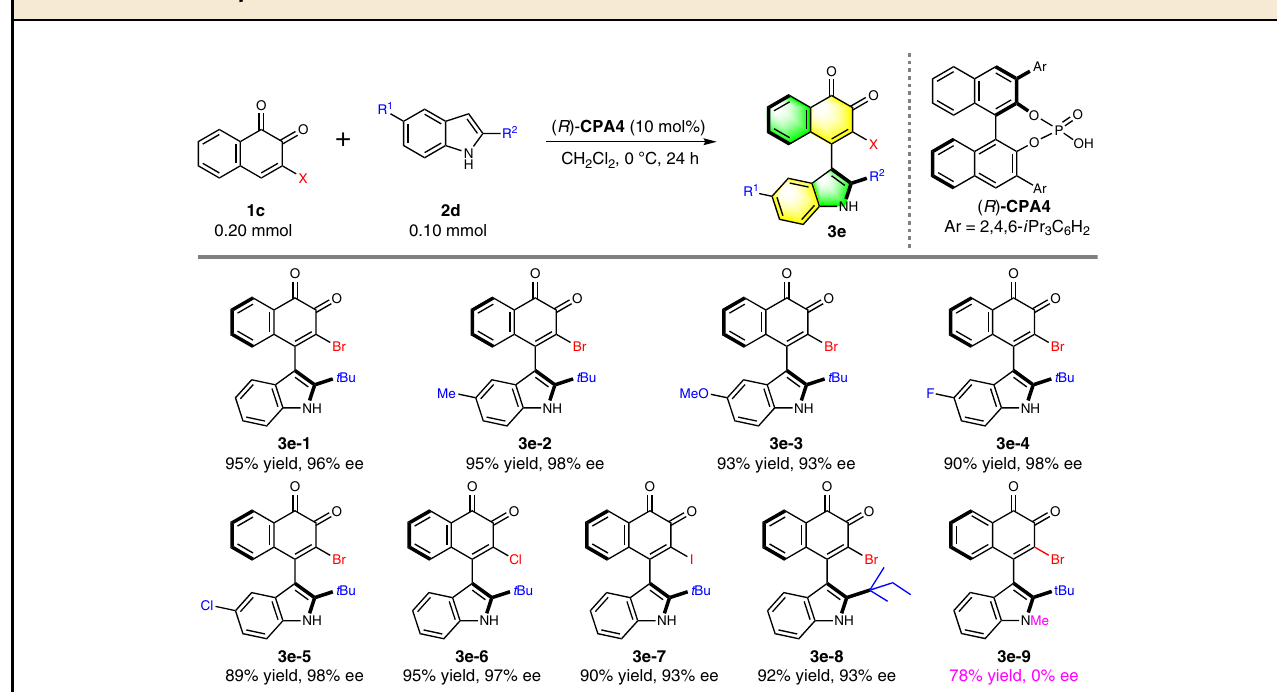
Table 6 Substrate Scope with Indole